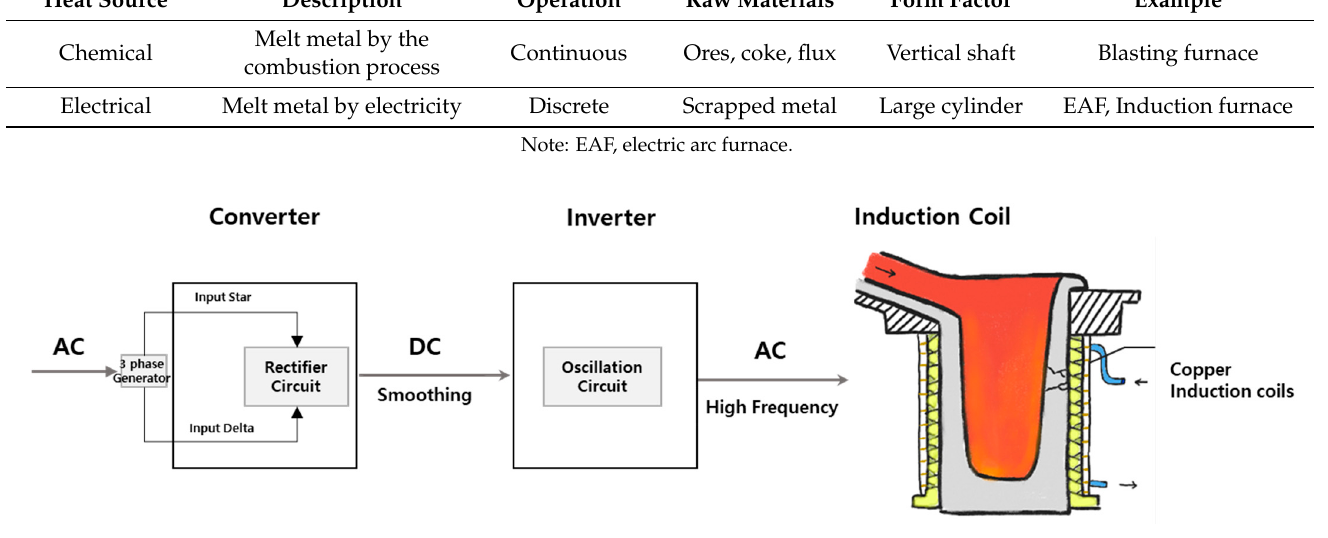
Figure 1. Electrical flow of induction furnace.